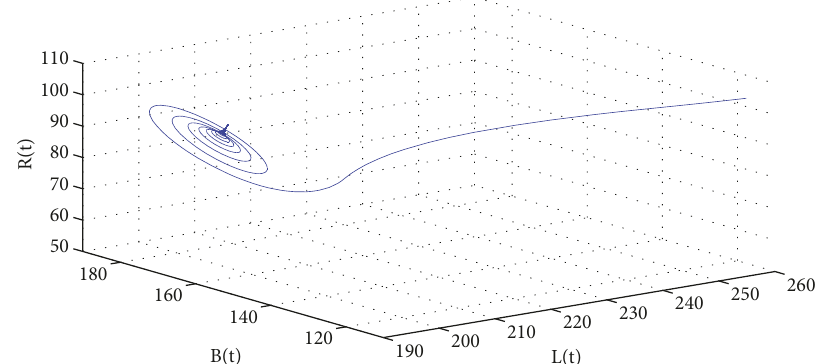
Figure 3: Dynamic behavior of system (61): projection on L-B-R with 𝜏 = 3.2575 < 𝜏 0 = 3.4685 .